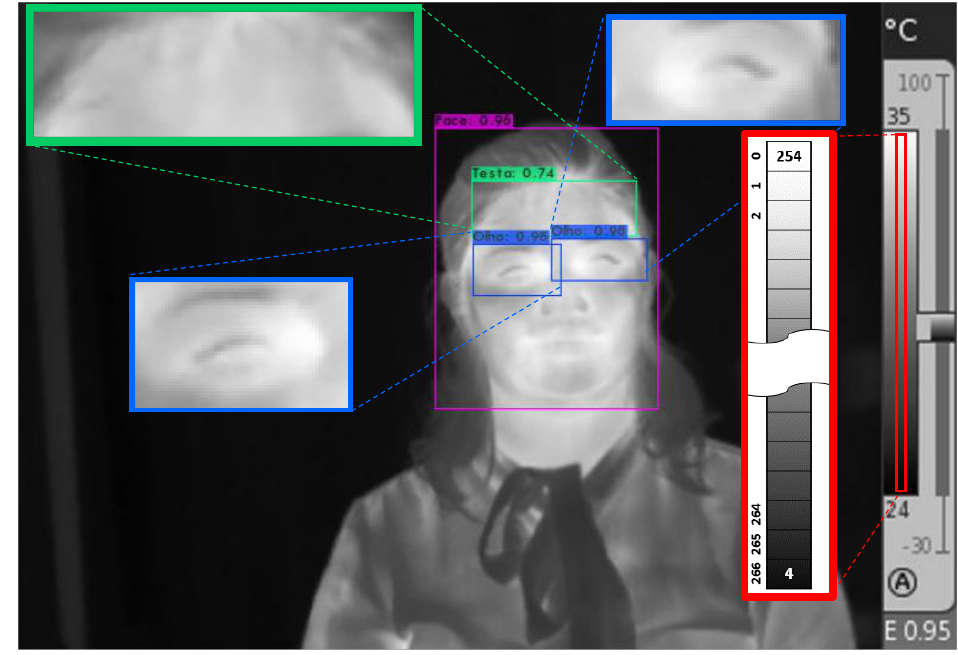
Figure 8. Extraction of ROIs to be analyzed.